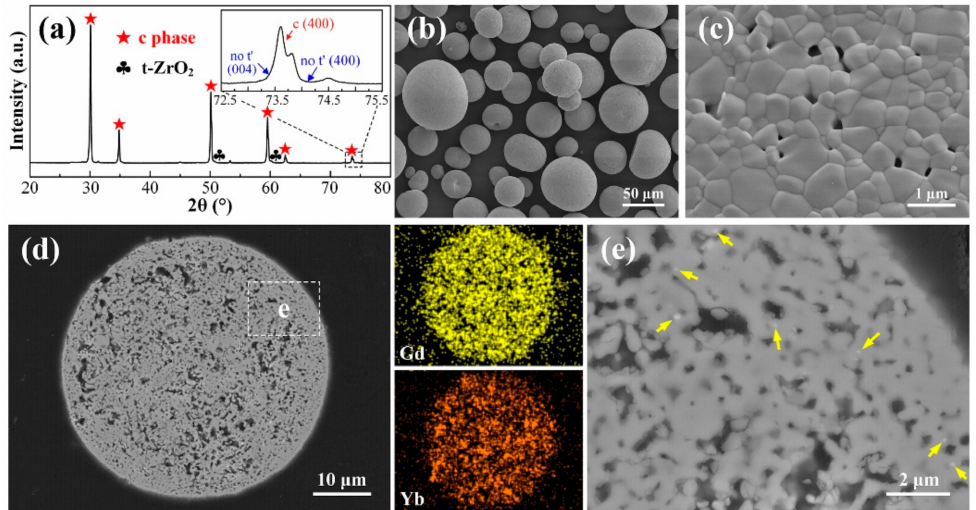
Figure 6. XRD pattern ( a ), surface morphologies ( b , c ), cross-sectional microstructure ( d , e ), corre- sponding EDS Gd and Yb mapping results of 10YGYZ agglomerated powders calcined at 1300 ◦ C for 3 h. ( e ) is the enlarged image of the marked region of ( d